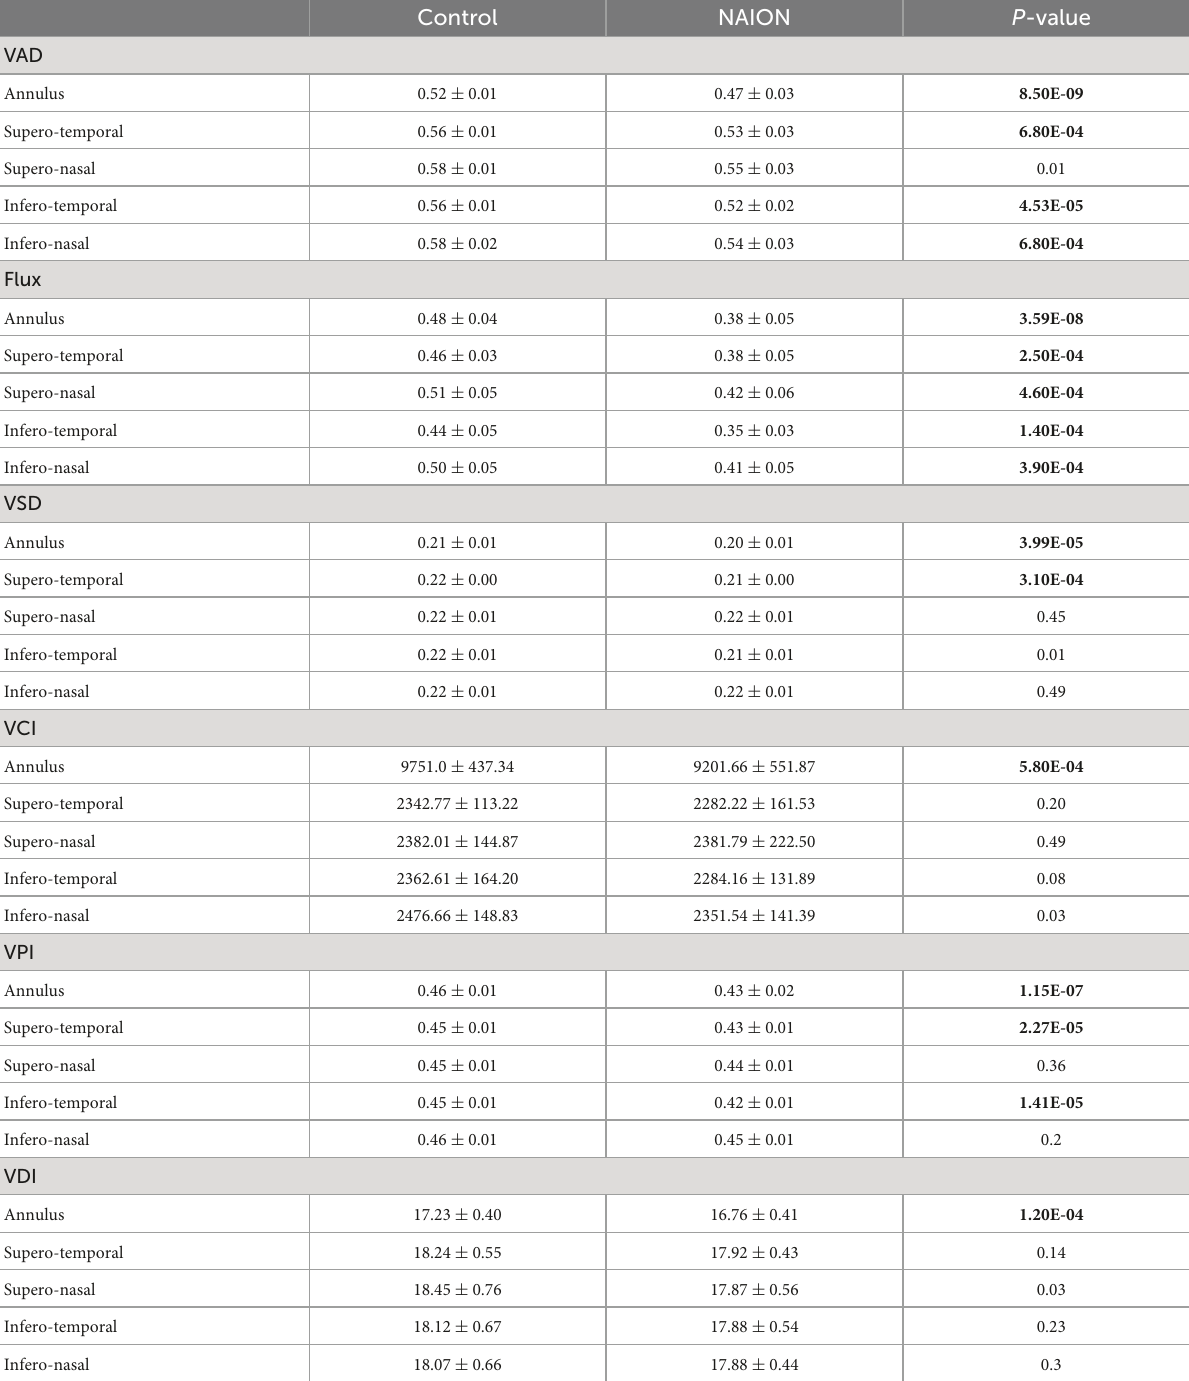
TABLE 3 Differences in macular annulus and cross-quadrant optical coherence tomography angiography (OCTA) parameters between controls and eyes with chronic non-arteritic anterior ischemic optic neuropathy (NAION).